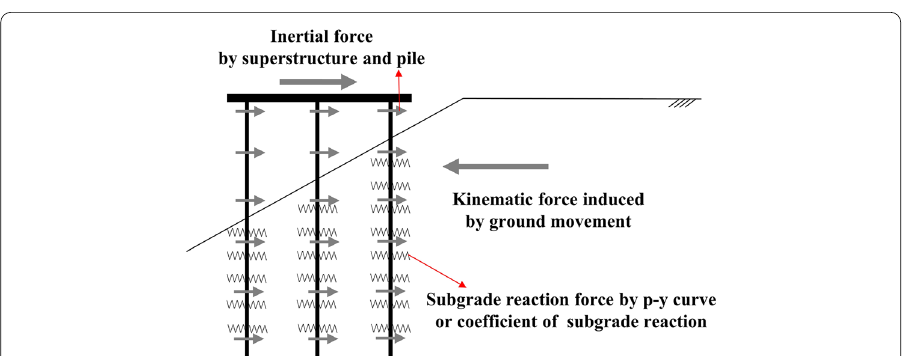
Fig. 2 Force components of pile foundation during earthquake